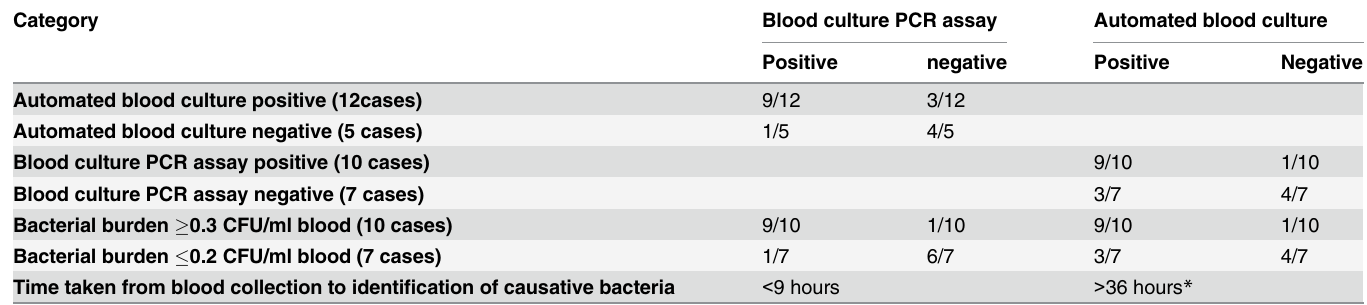
Table 1. Performance of blood culture PCR assay and automated blood culture in participants diagnosed with paratyphoid fever (n =